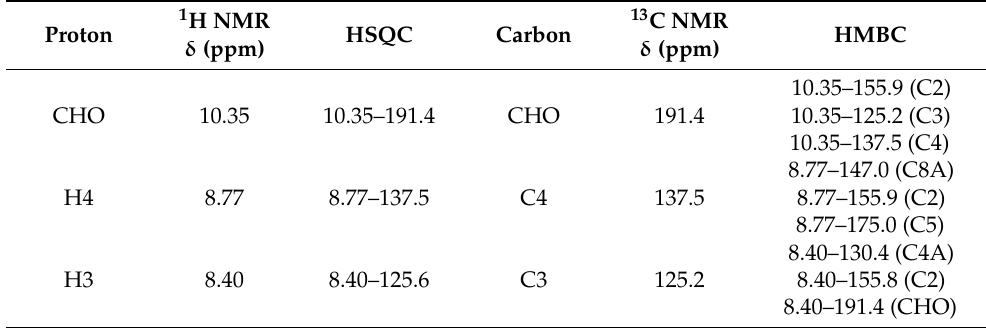
Table 1. The chemical shifts ( 1 H NMR and 13 C NMR spectra) and correlations proton–carbon (HSQC and HMBC experiments) for derivative 3 .